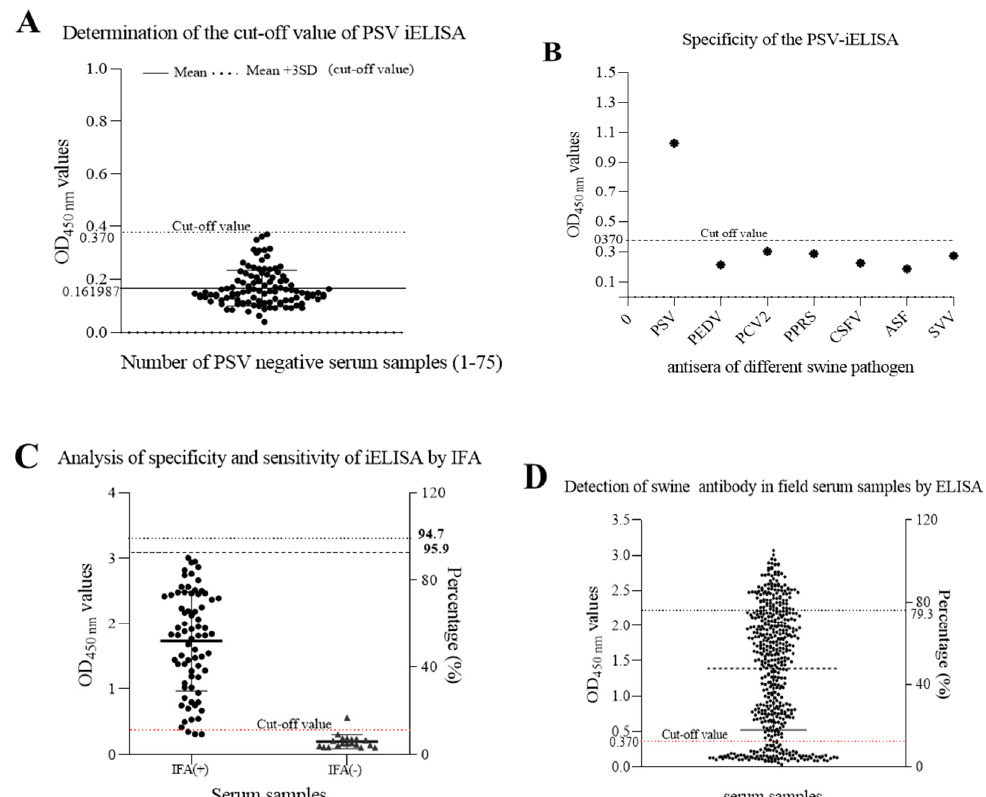
Figure 7. Detection of anti-PSV antibodies in swine serum by the developed iELISA. ( A ) seventy-five PSV-negative serum samples were tested using iELISA and the mean OD 450 value of PSV-negative serum plus three standard deviations (SDs) were used to calculate the cutoff value. ( B ) Identification of iELISA specificity by cross-reaction test. Positive swine serum against PSV, PEDV, PCV2, PRRS, CSFV, ASFV and SVV were tested by iELISA. The average of OD 450 values were calculated to determine the tested serum according to the cut-off value. ( C ) The sensitivity and specificity of the developed ELISA were assessed based on the IFA result. ( D ) Detection of anti-PSV antibodies from field swine serum samples by the developed iELISA.